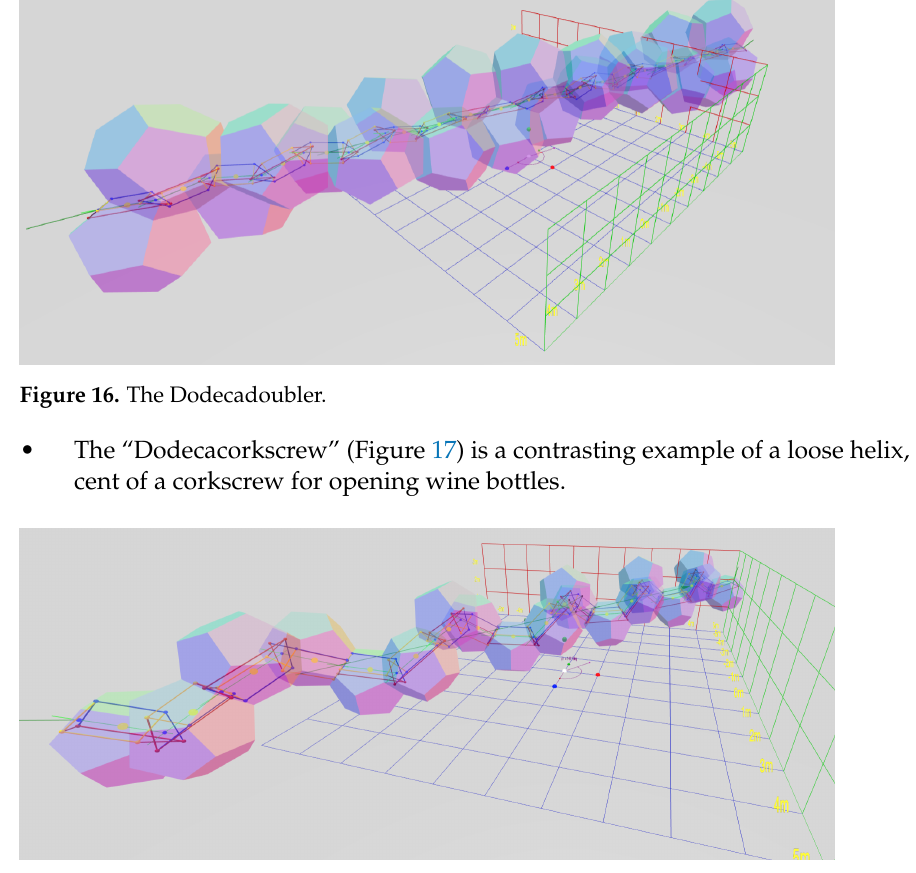
Figure 17. The Dodecacorkscrew.